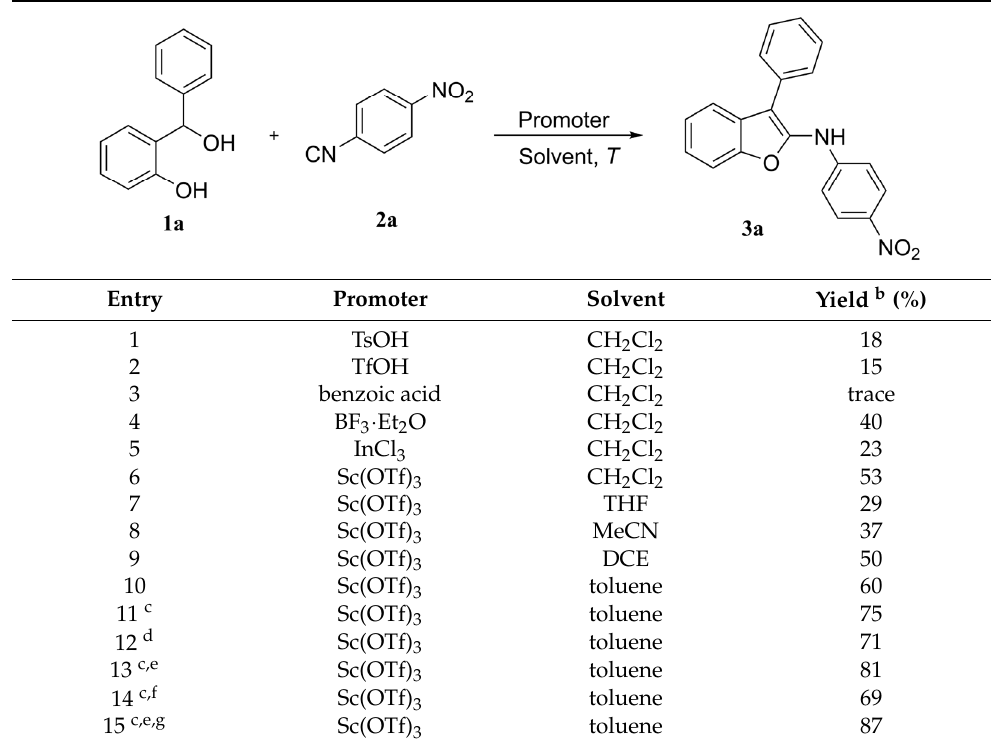
Table 1. Optimization of reaction conditions a .